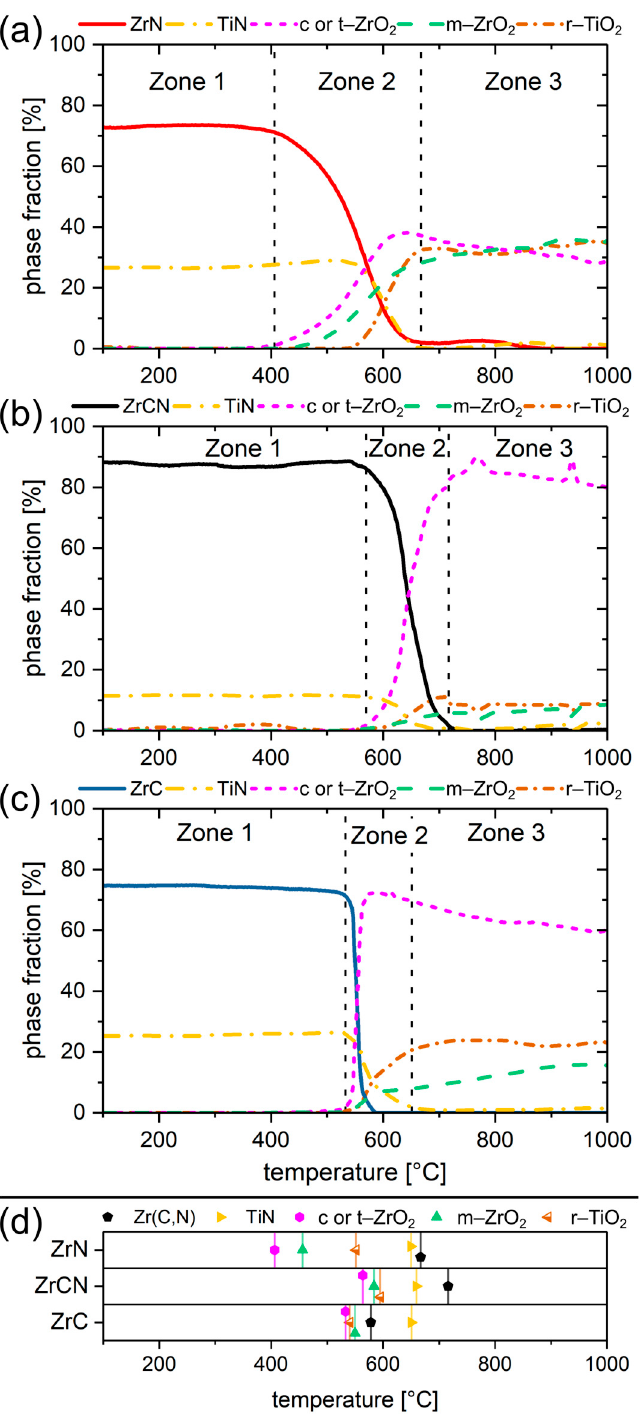
Figure 5. Quantitative phase evolution as a function of the oxidation temperature for ( a ) ZrN, ( b ) ZrCN and ( c ) ZrC, obtained by parametric Rietveld refinement. ( d ) The oxidation onset tem- peratures of the oxide phases (c or t–ZrO 2 , m–ZrO 2 and r–TiO 2 ), as well as the temperature of full oxidation of the Zr(C,N) and TiN phases for the ZrN, ZrCN and ZrC sample,